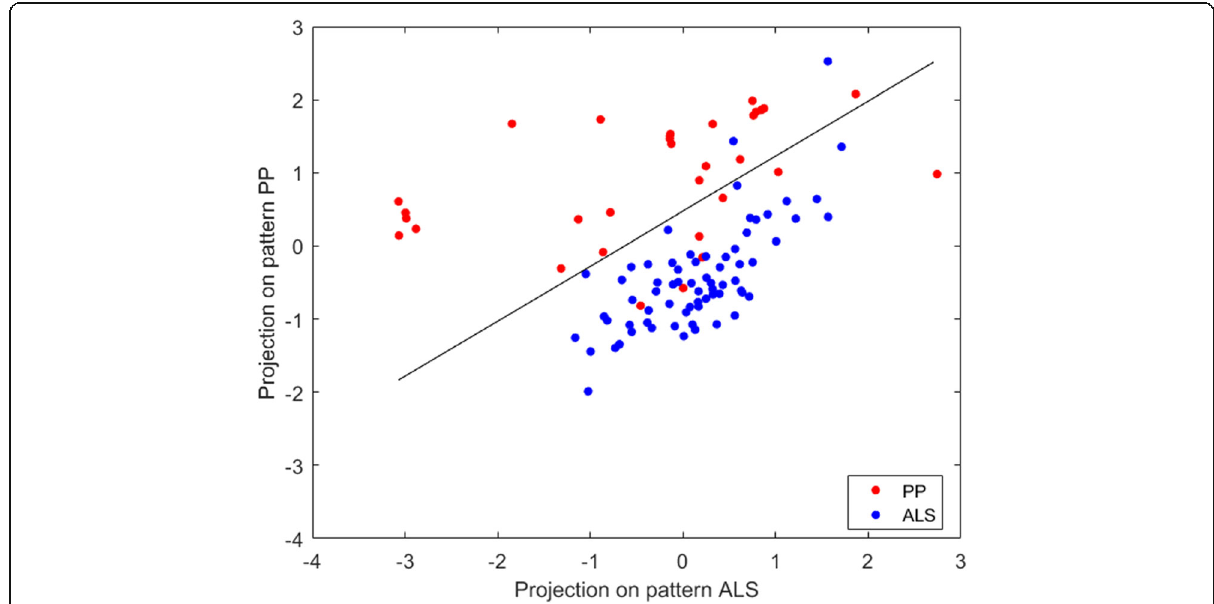
Fig. 5 Individual ALS- and PP-specific pattern expression scores by projecting the corresponding 18 F-FDG PET scan onto a ALS- and PP-specific metabolic brain pattern as determined by PCA-SVM. A linear SVM is used classify both groups based on these disease expression